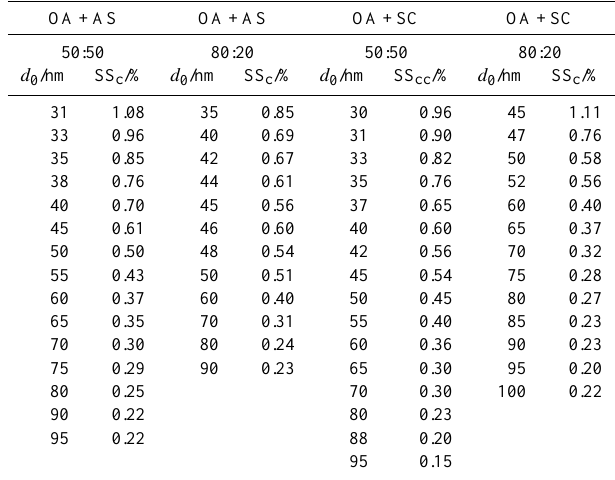
Table 6. Measured critical supersaturation as a function of dry par- ticle diameter for the studied mixtures (abbreviations are explained in Table